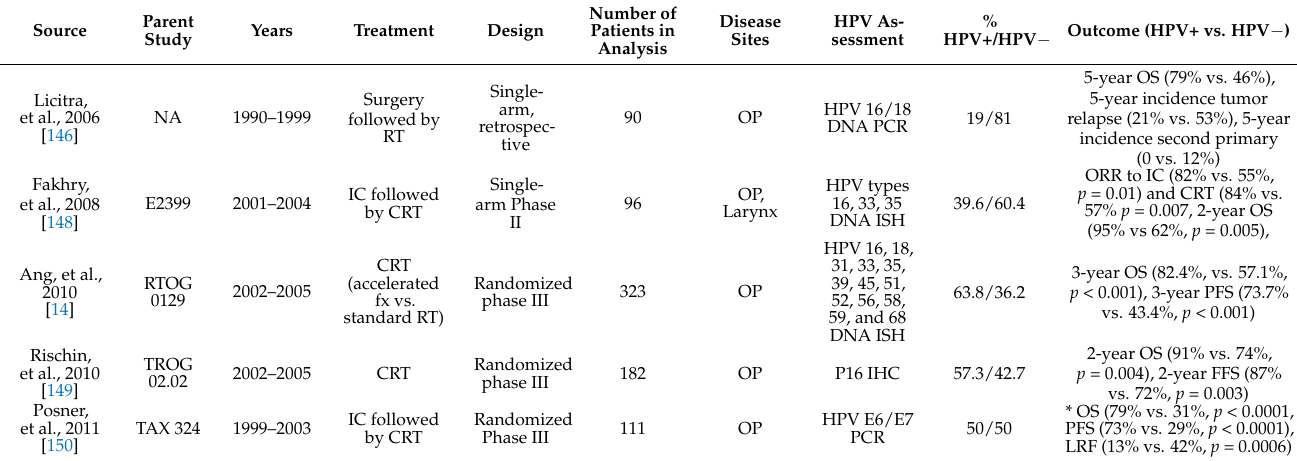
Table 2. Key multimodality treatment trials demonstrating improved outcome in HPV+